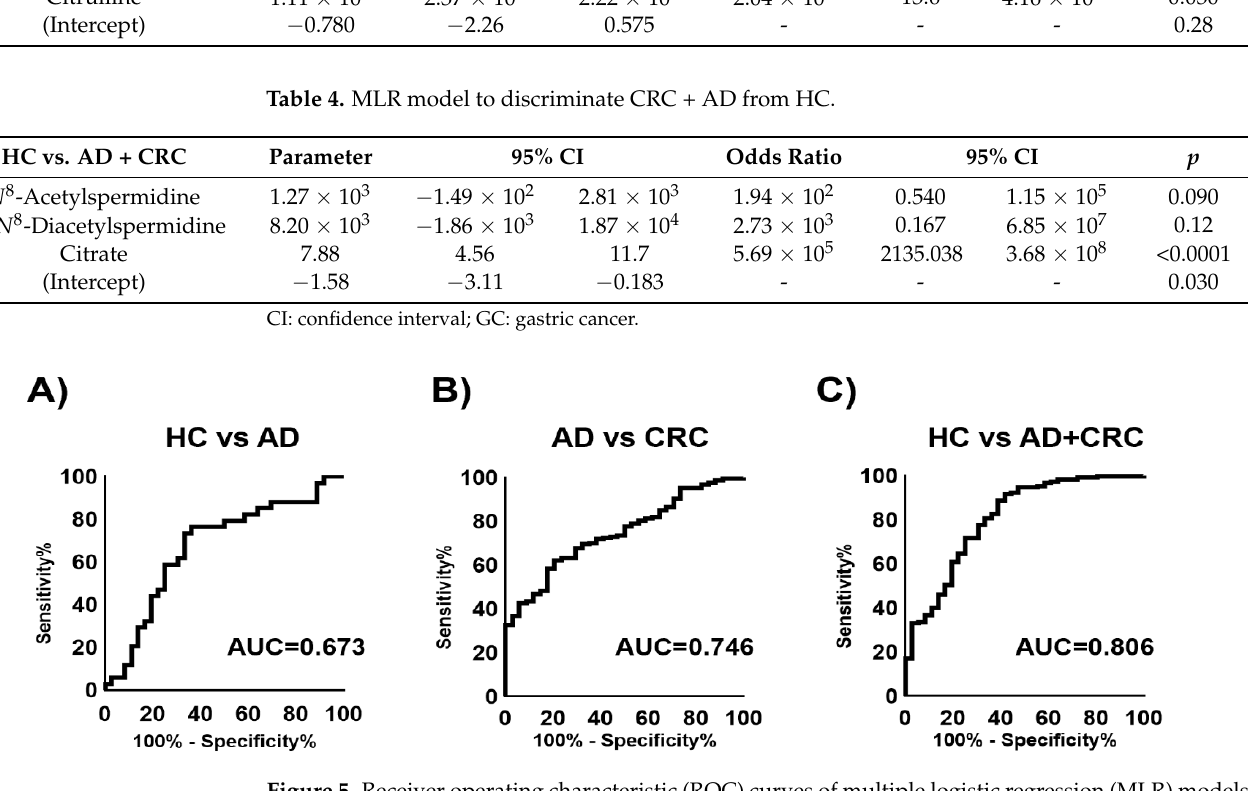
Figure 6. Comparison of metabolite concentrations between HC vs. AD + CRC in the TCA cycle, glutamine pathway, urea cycle, and polyamine pathways. The datasets include both data 1 and data 2. ** p < 0.01, *** p < 0.001, and **** p < 0.0001 (Mann–Whitney U test). ”ND” is “No Data”.